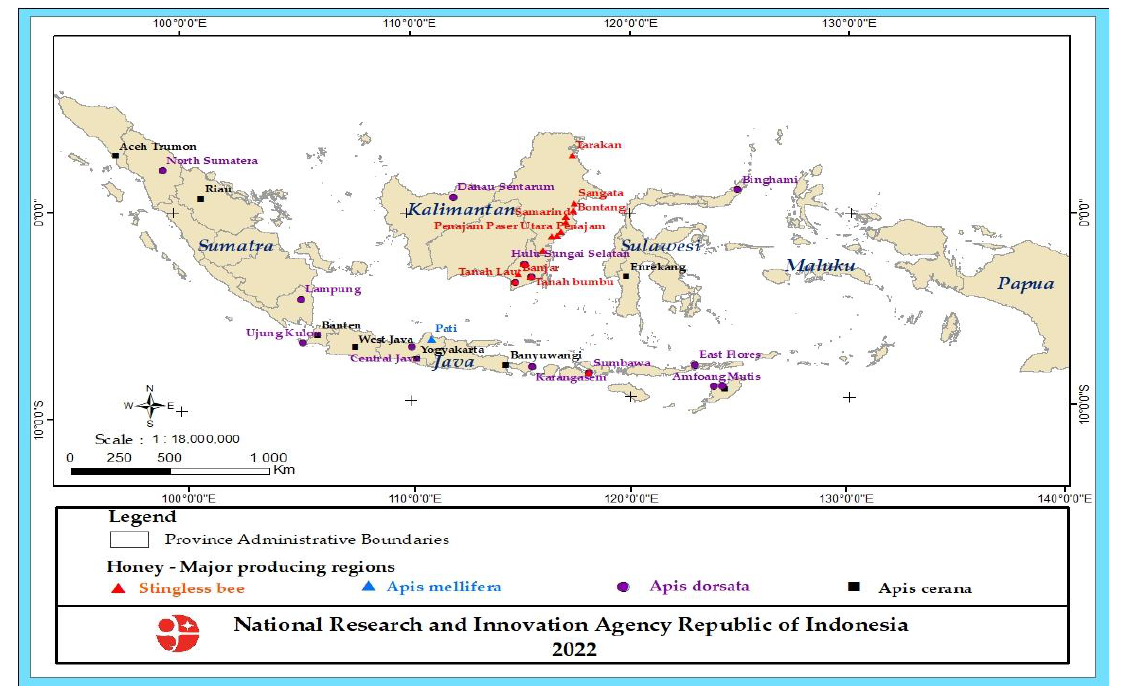
Figure 1. The distribution of major honey producing bees in Indonesia (Source: [3,28,29,31–33,40,84, 86,237,243–245]).